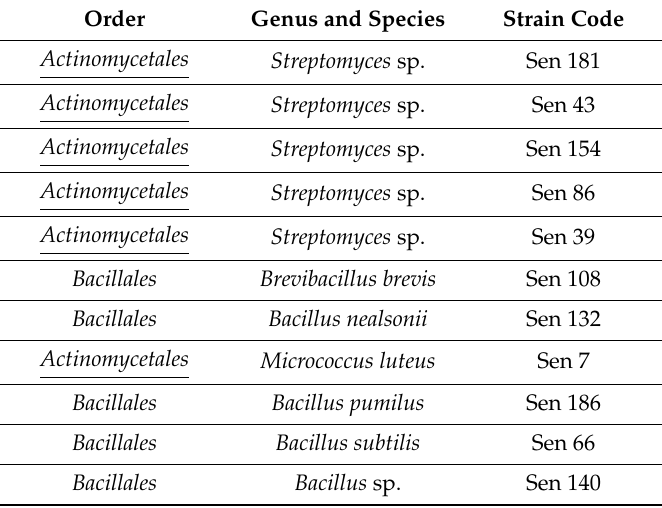
Figure 4. Maximum-likelihood phylodendrogram of Streptomyces spp., including the species isolated in the present study based on the partial 1000-bp sequence of the 23S rRNA gene. Table 1. Isolated strains used in the